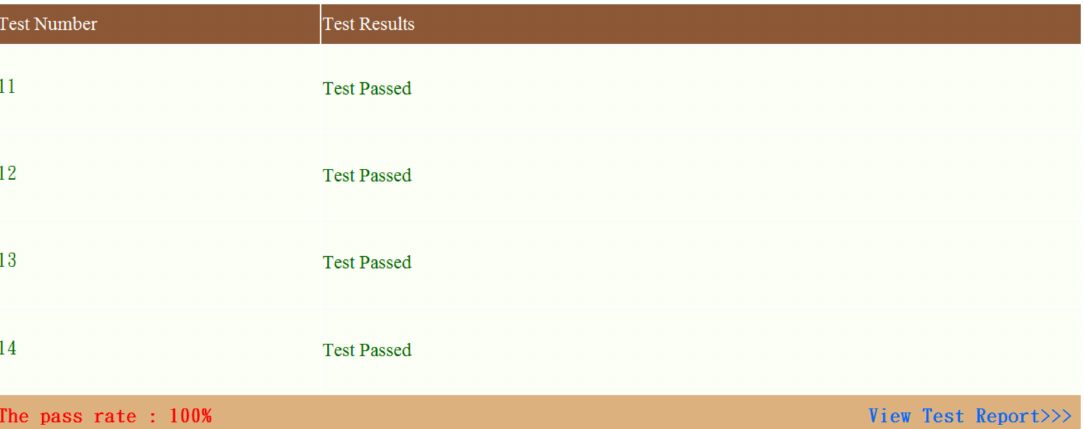
Figure 18. Test result after modifying program